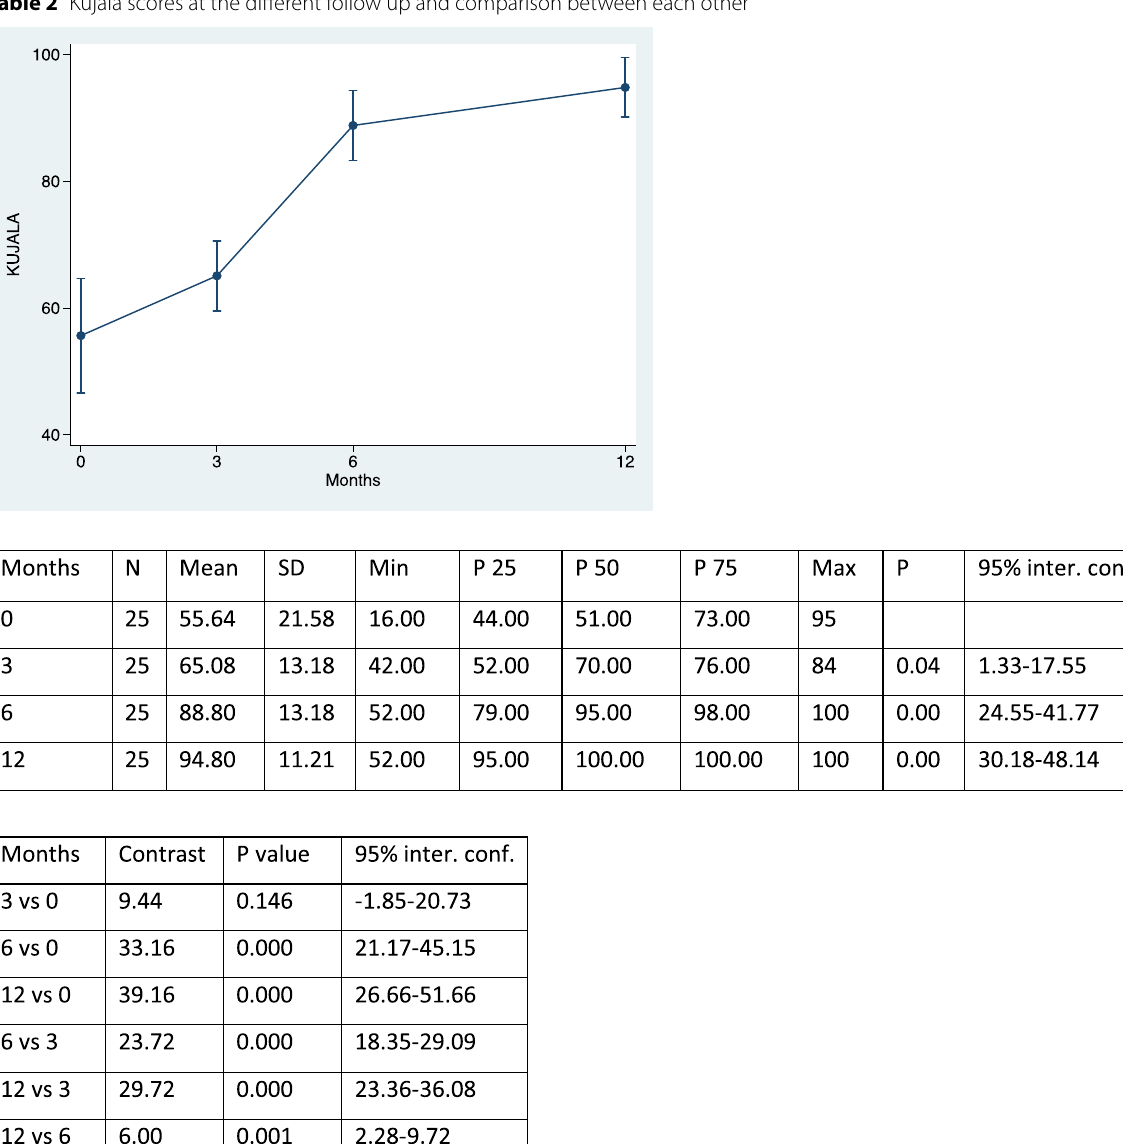
Table 2 Kujala scores at the different follow up and comparison between each